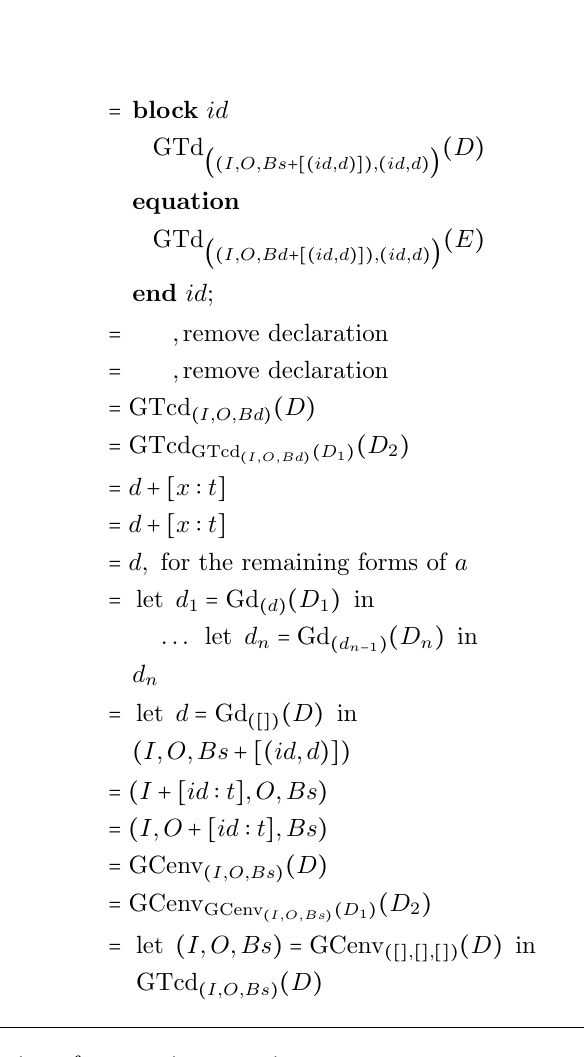
Figure 14: Generation of connection